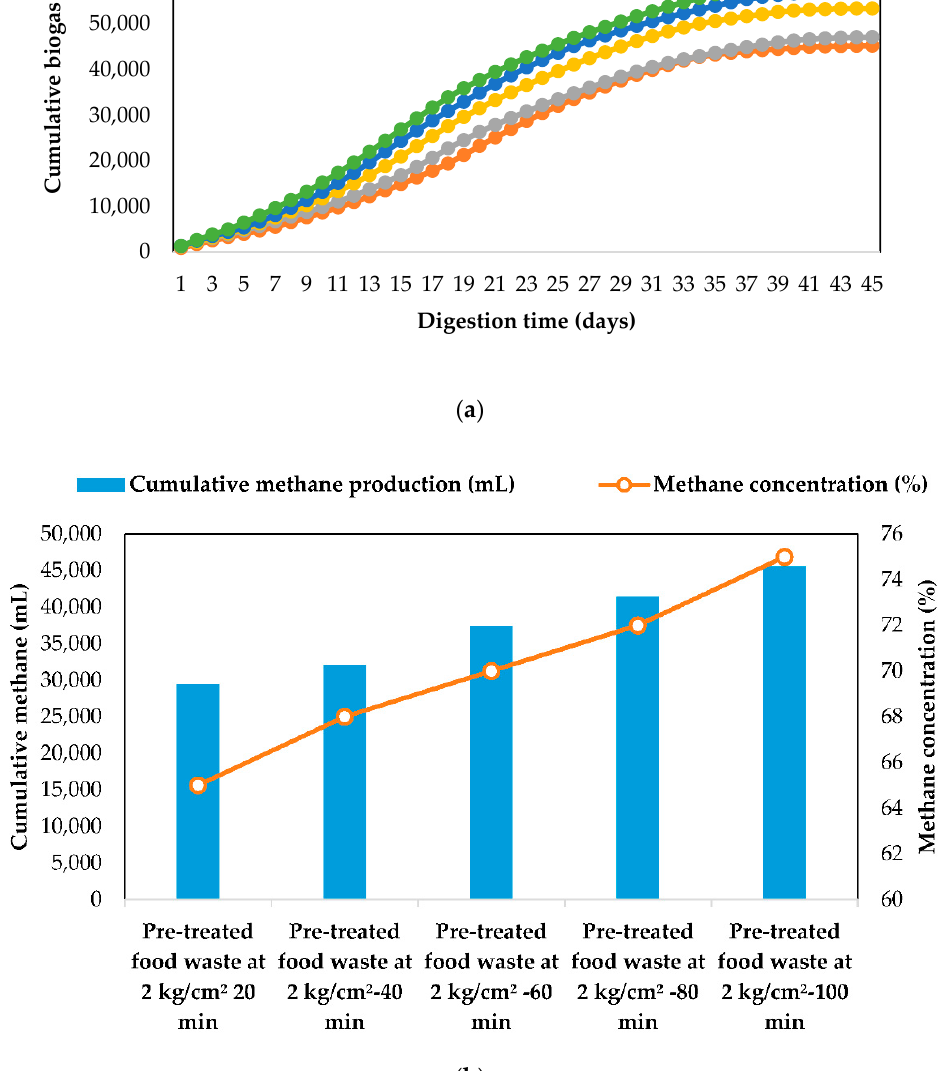
Figure 4. Biogas and methane profile for pretreated food waste at different time duration at 2-kg/cm 2 pressure. ( a ) Cumulative biogas generation profile at different time duration of pretreatment; ( b ) cumulative methane generation profile along with methane concentrations.